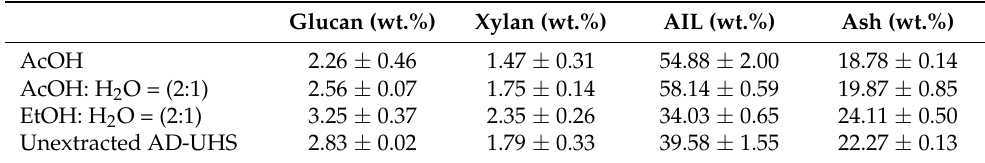
Table 4. Compositional analysis of the left-over solids after extraction with three solvents. Glucan (wt.%) Xylan